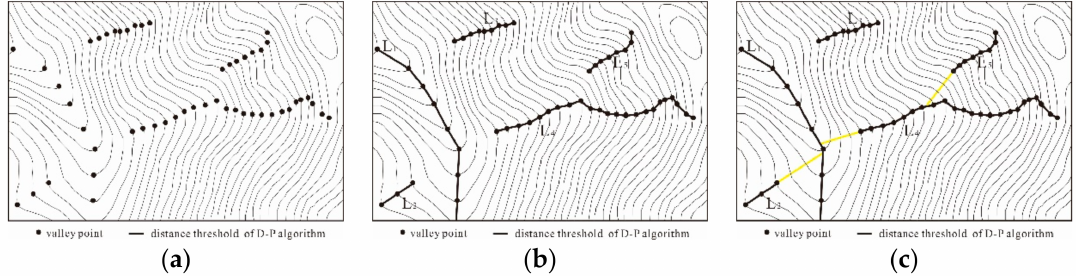
Figure 9. Connection of terrain feature lines: ( a ) terrain feature points, ( b ) terrain feature lines, and ( c ) compensation of terrain feature